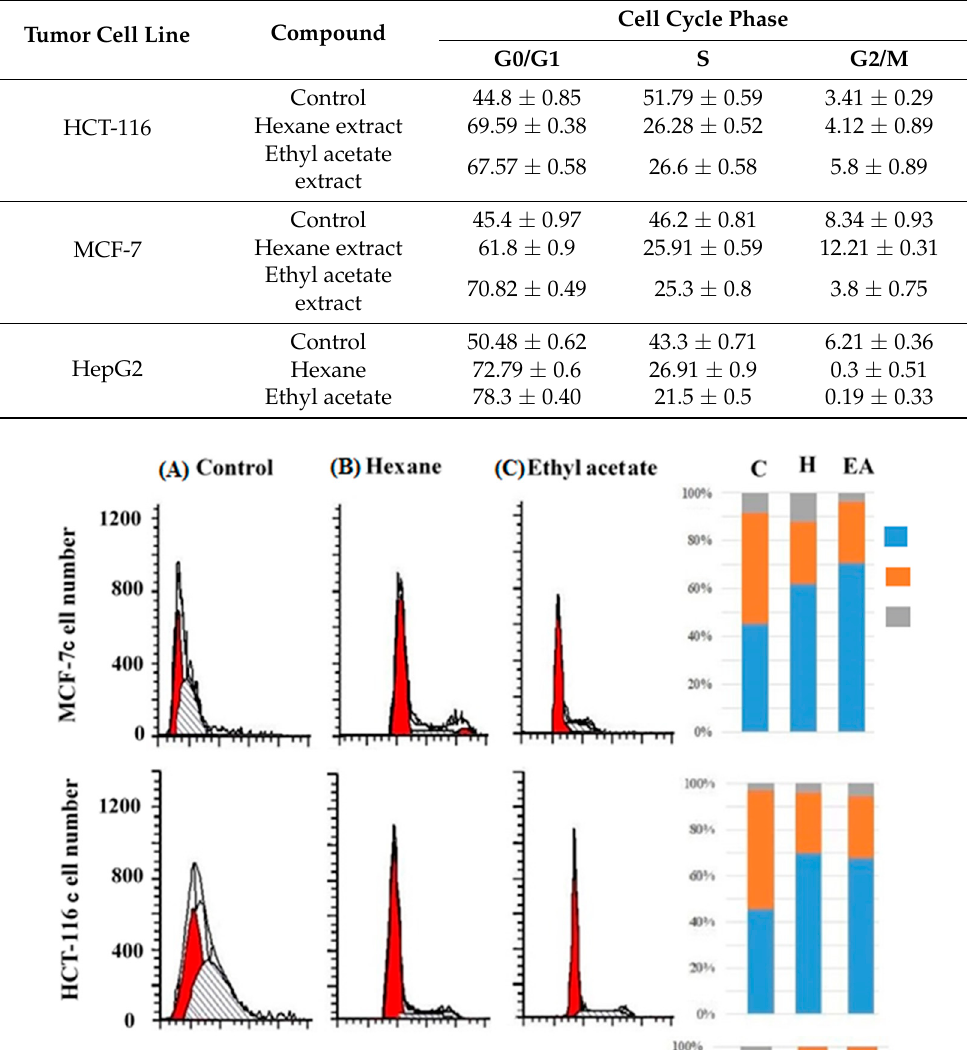
Table 2. Effects of hexane and ethyl acetate extracts of A. lagopoides on the cell cycle distribution of three tumor cell lines over 24 h, compared with control cells.